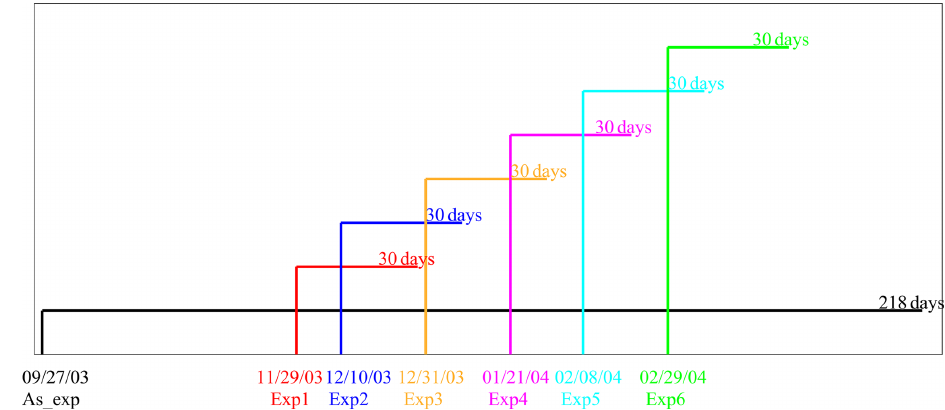
Figure 4. The settings of assimilation and six forecast experiments, including the start dates and durations.